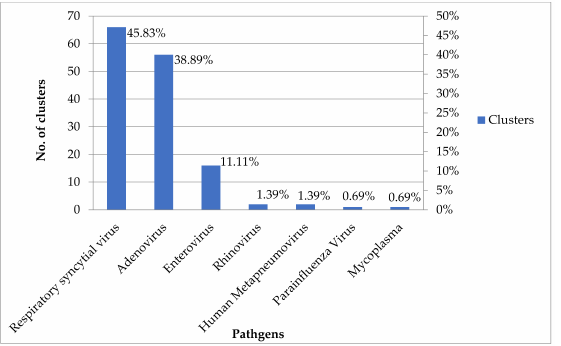
Figure 2. The number and percentage of non-influenza respiratory viruses among URTI clusters, Taiwan, 2011–2019. URTI: upper respiratory tract infection.